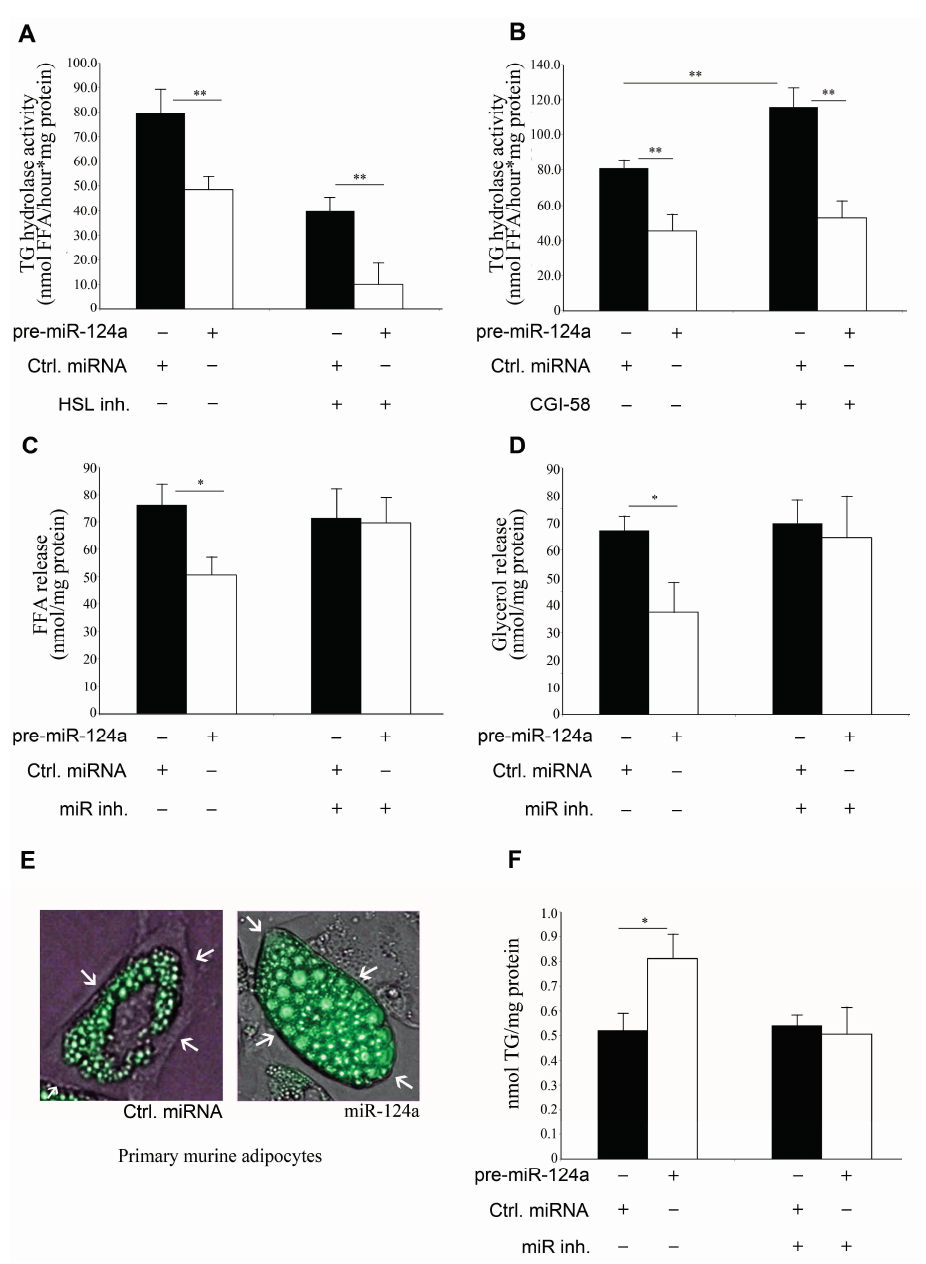
Figure 3. miR-124a negatively regulates lipolysis ( A , B ) OP9 adipocytes were transfected Z787632 with either control pre-miRNA or pre-miR-124a. TG hydrolase activities were analyzed in the presence or in the absence of 76-0079 (HSL inhibitor) ( A ) or 500 ng recombinant CGI-58 protein ( B ); ( C , D ) free fatty acid ( C ) and glycerol ( D ) release was quantified in OP9 adipocytes after transfection with either pre-miR-124a or control pre-miRNA with or without miR-124a inhibitor; ( E ) Primary mouse adipocytes transduced with lentiviral particles carrying either control pre-miRNA or miR-124a were stained with BODIPY 493/503 fluorescence dye; White arrows point towards the differences in lipid droplet size ( F ) OP9 adipocytes were transfected with either pre-miR-124a or control pre-miRNA with or without miR-124a inhibitor and cellular triglyceride (TG) was quantified. Data are shown as average ± standard deviation and represent three independent experiments. ** p < 0.01, * p <